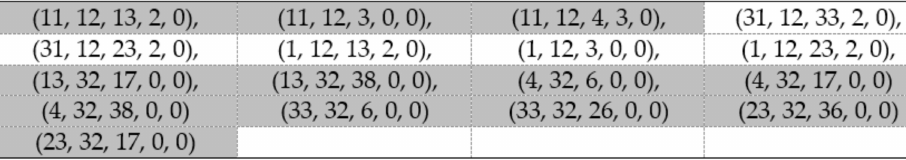
Figure 8. Two input sets of the nested-loop join